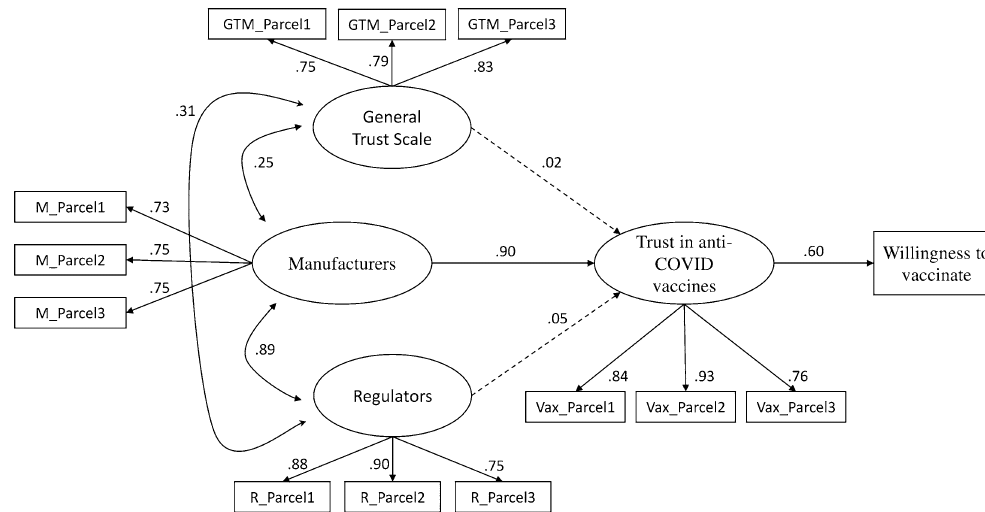
Figure 2. Dynamics of trust on manufacturers, regulators, and peers and their impact on confidence in vaccines and vaccination intention. Fit indexes: χ 2 test of model fit = 1553.43; df = 59 ( p < 0.001); Comparative Fit Index (CFI) = 0.946; Root Mean Square Error of Approximation (RMSEA) = 0.079 (90% CI 0.075–0.082); Standardized Root Mean squared Residual (SRMR) = 0.040). Scaling Correction Factor for MLR = 1.14. Parameters estimates are standardized. Dotted lines represent not significant relationships. Continuous lines represent paths with p <